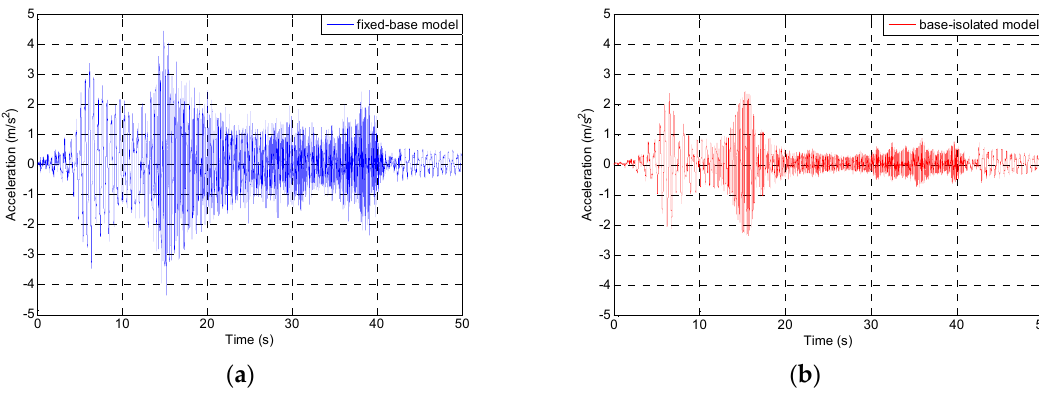
Figure 10. Time-acceleration history plots for the fixed-base ( a ) and base-isolated ( b ) two-storey model during the sine sweep test.